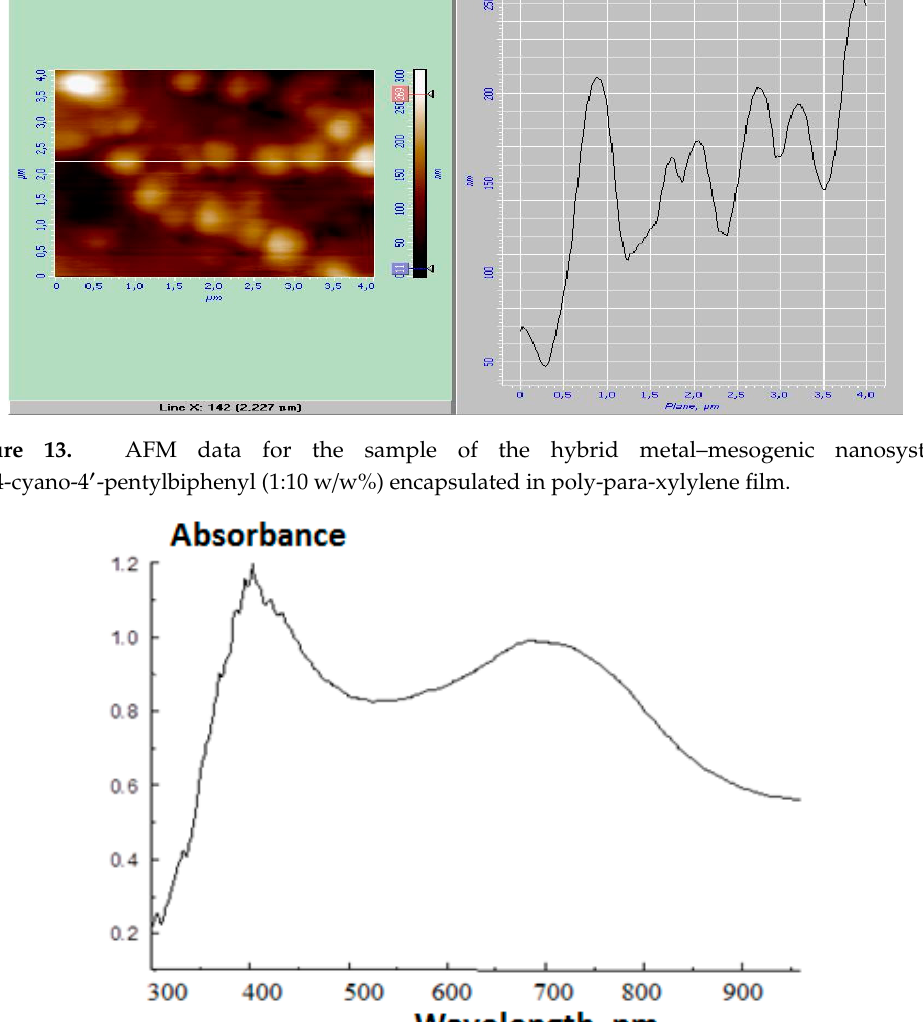
Figure 12. X-ray data for sample of hybrid metal–mesogenic nanosystem Ag/4-cyano-4 ′ - pentylbiphenyl (1:10 w/w%), encapsulated in poly-para-xylylene (PPX) film at 450 K ( а ), 300 K (b), 250 K ( c ), and 200 К ( d ) (Y-axis is the intensity of the signal in related units).